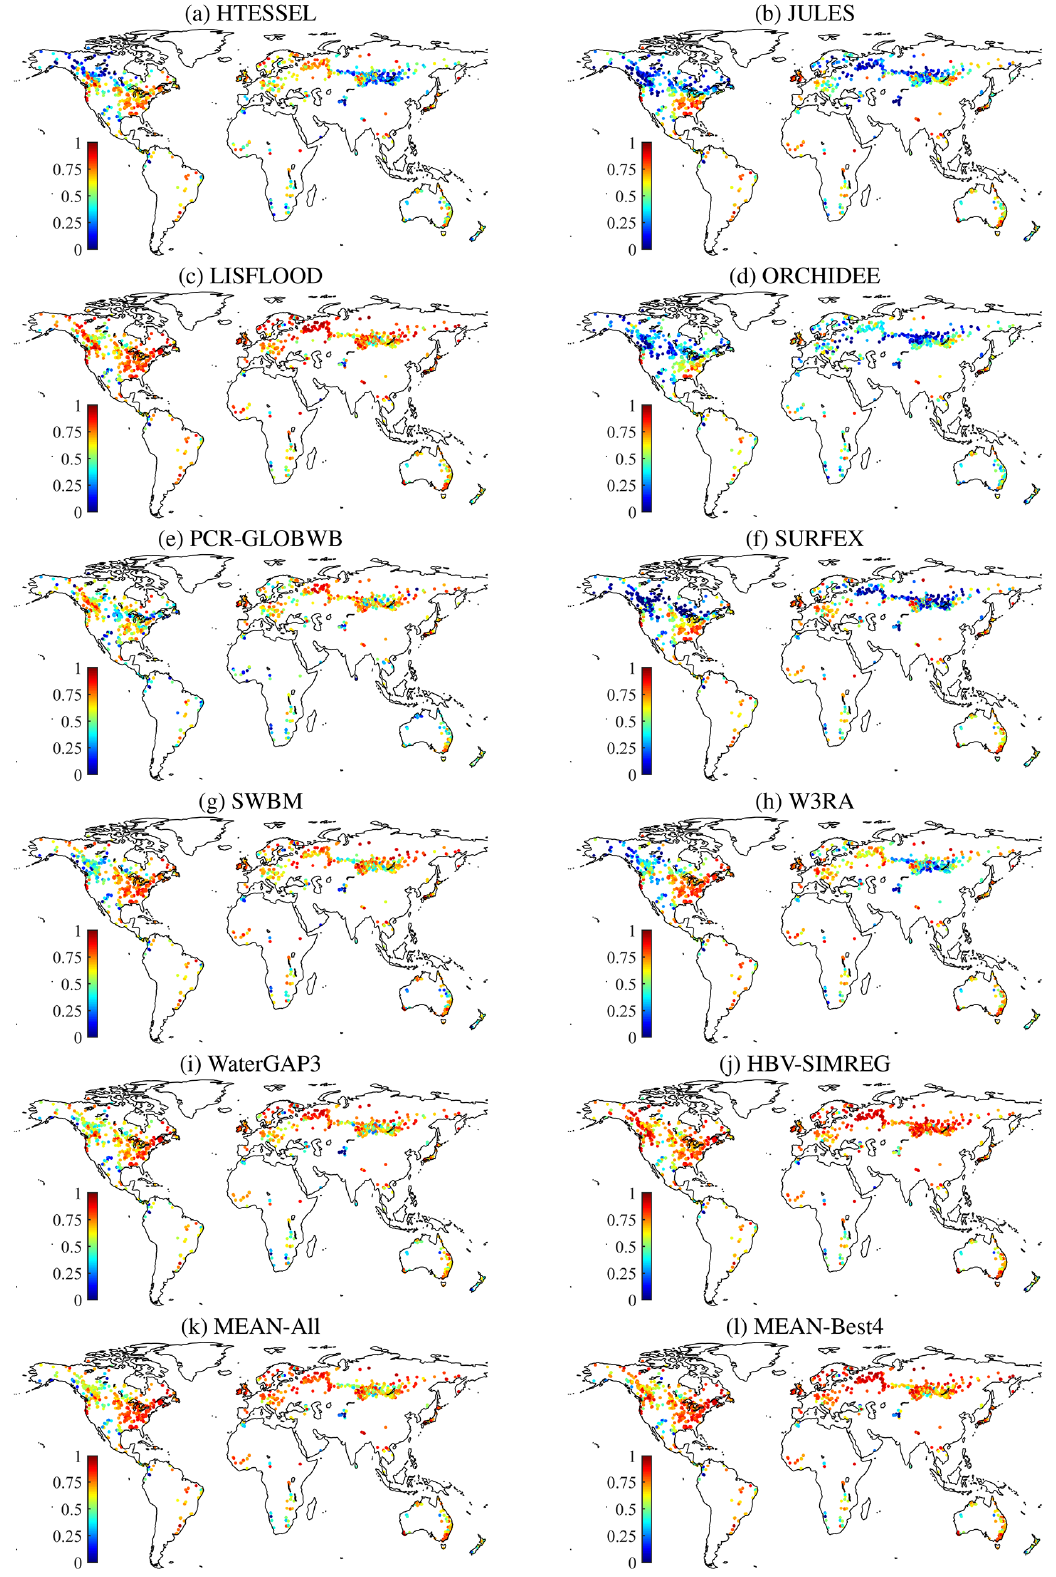
Figure 2. Correlation coefficients calculated between simulated and observed monthly runoff ( r mon ; unitless) for the catchments. Each data point represents a catchment centroid ( n =